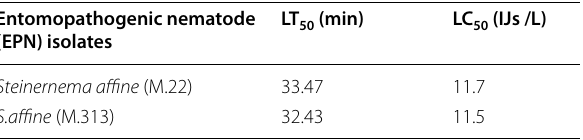
Table 6 LC and LT values calculated by the Probit analysis for 50 50 M.22 and